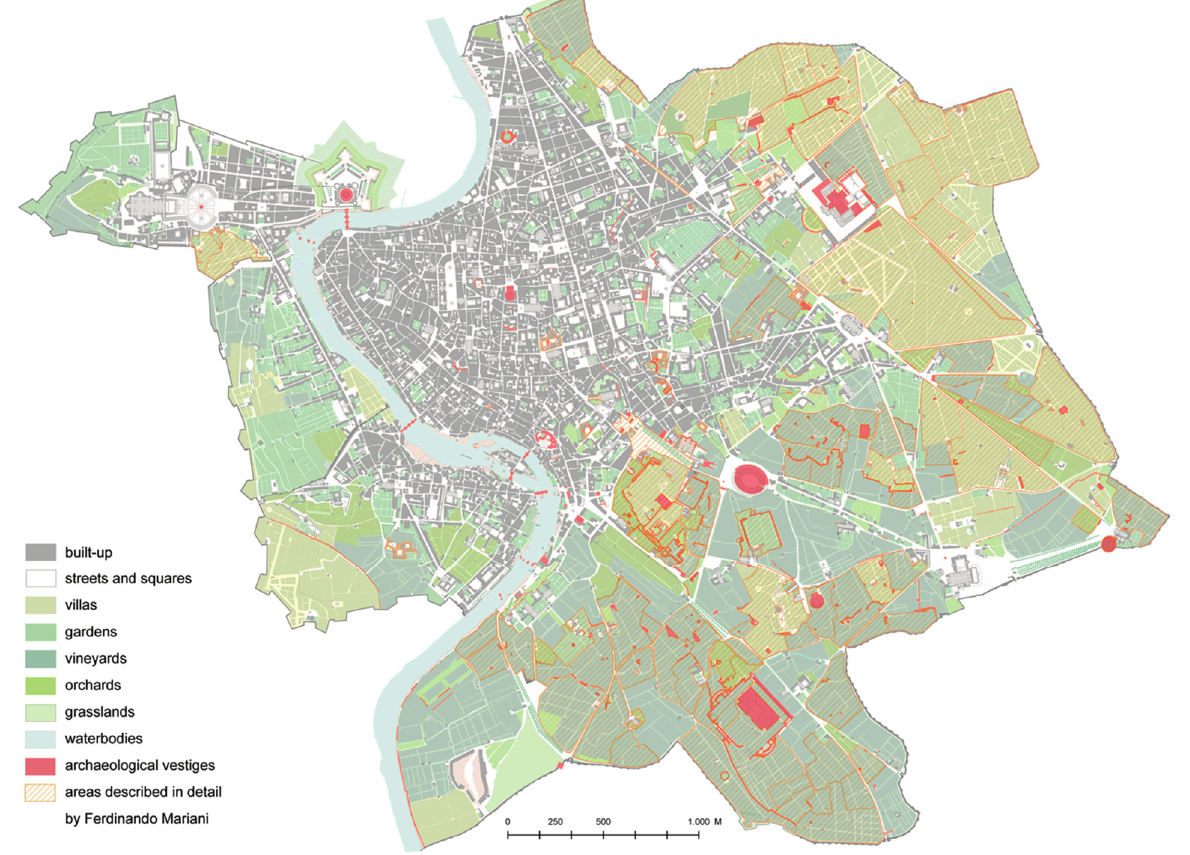
Figure 11. Land use map of Rome in the 18th century with evidenced archaeological